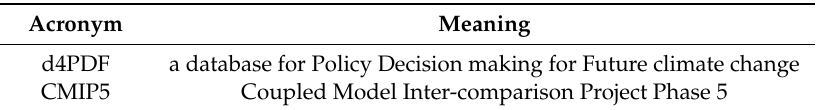
Table 2. Meaning of acronym.